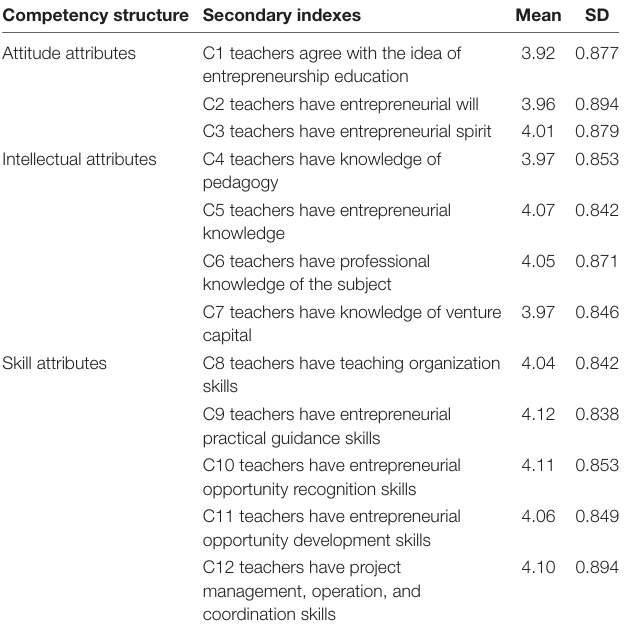
TABLE 2 | structure of teachers’ competencies of entrepreneurship education.